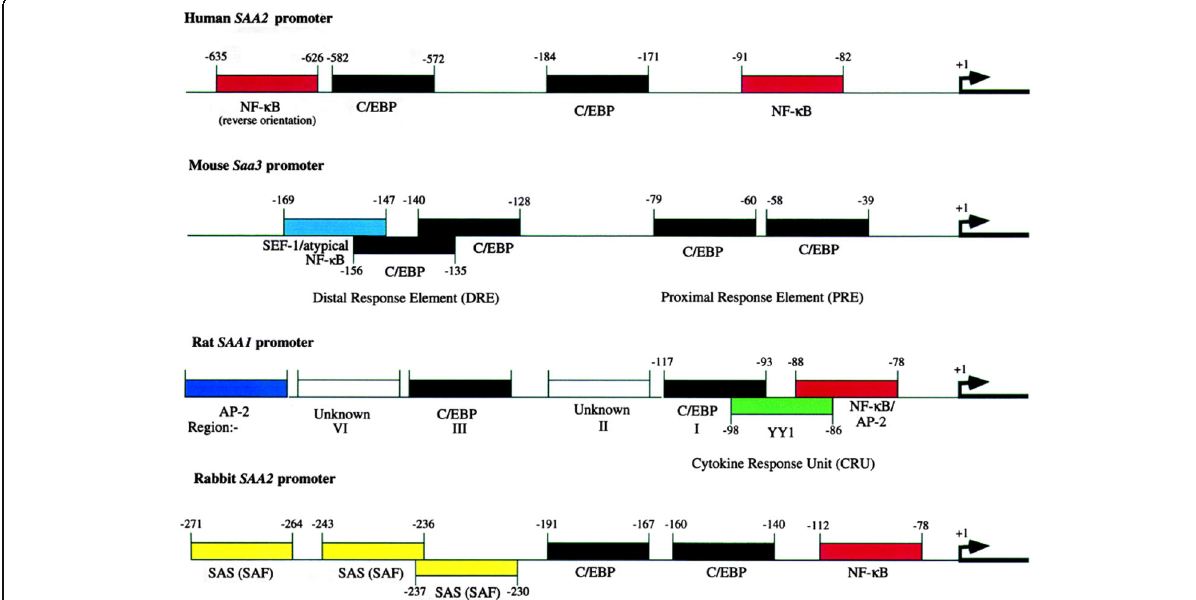
Fig. 6 Promoter maps for mammalian SAA genes showing regions for transcription-factor binding. Transcription begins at the arrow (+1). Sites are identified for NF- κ B, C/EBP, AP-2, SAS (binds SAF and SEF-1) and YY1. SEF is a factor identified in the mouse distal response element. (Uhlar and Whitehead (1999a), Copyright John Wiley and Sons, 2011, used by